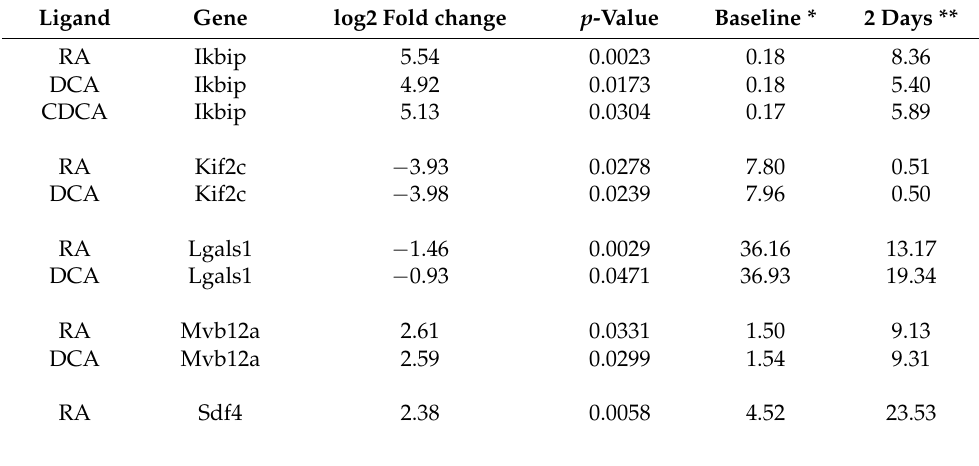
Table 1. Genes whose changes in expression were similar in RA and DCA or CDCA treated NCE34